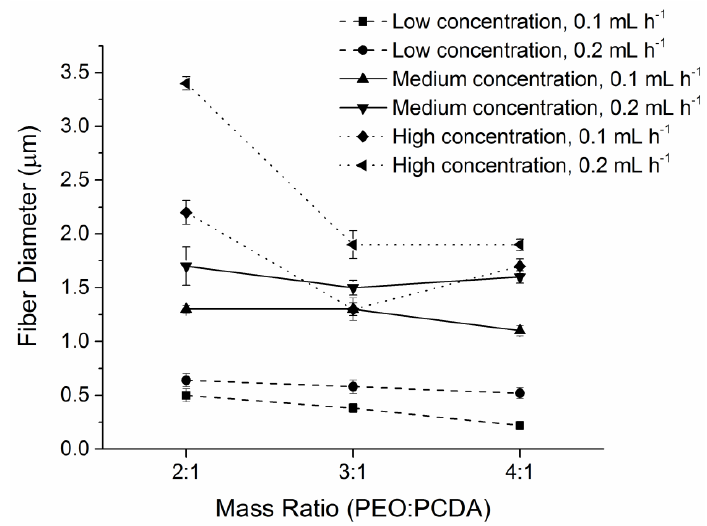
Figure 2. Fiber diameters are illustrated as a function of polymer concentration, mass ratios of PEO and PCDA, and injection speed. The injection speed used was 0.1 mL·h −1 ( ■ , ▲ ♦ ) and 0.2 mL·h −1 ( ● , ▼ , ◄ ), respectively. Finer fibers were formed at higher mass ratios, lower concentrations, and the lower injection speeds.